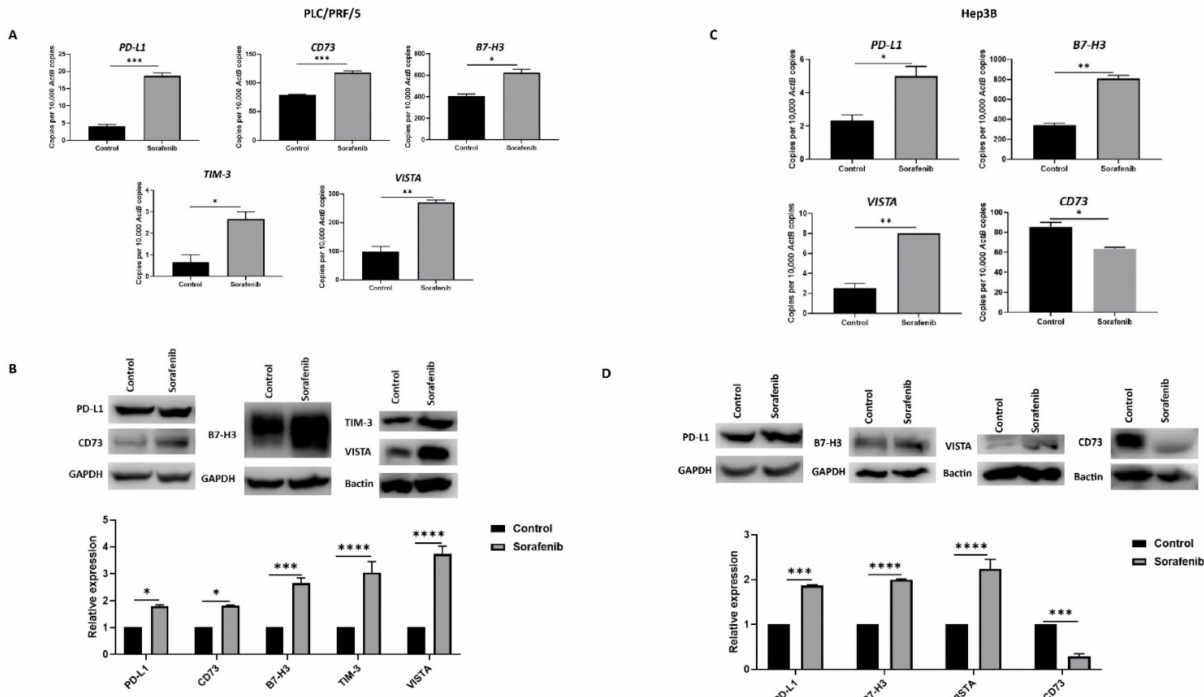
Figure 2. Sorafenib treatment induces immune checkpoint expression in HCC cells. ( A ) qRT-PCR demonstrated upregulation of immune checkpoint molecules PD-L1, CD73, B7-H3, VISTA, and TIM-3 in PLC/PRF/5 cells upon treatment with Sorafenib. ( B ) Western blot analysis revealed increased expression of PD-L1, CD73, B7-H3, VISTA, and TIM-3 in PLC/PRF/5 cells upon treatment with Sorafenib. GAPDH and Bactin were used as loading control. ( C ) qRT-PCR demonstrated upregulation of immune checkpoint molecules PD-L1, B7-H3, and VISTA and downregulation of CD73 in Hep3B cells treated with Sorafenib. ( D ) Western blot analysis revealed increased expression of PD-L1, B7-H3, and VISTA and decreased expression of CD73 with minimal expression of TIM-3 in Hep3B cells post Sorafenib treatment. GAPDH and Bactin were used as loading control ( n = 3, * p < 0.05, ** p < 0.01, *** p < 0.005, **** p <